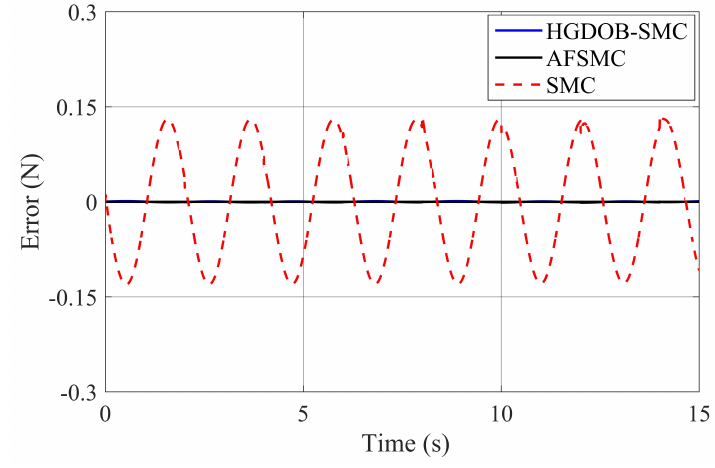
Figure 9. Tension tracking error.